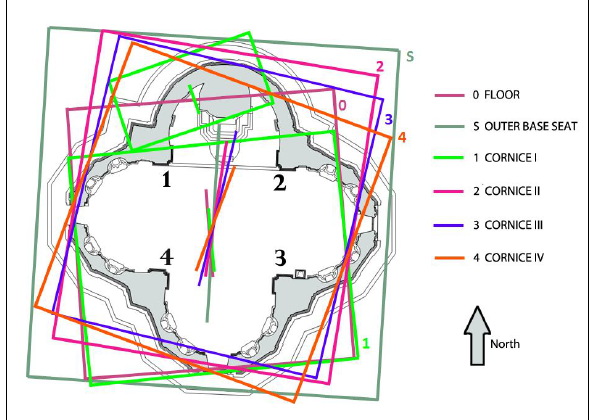
Figure 6. Superimposition of the maximum slope directions for architectural elements at different levels (ref. Fig. 5)